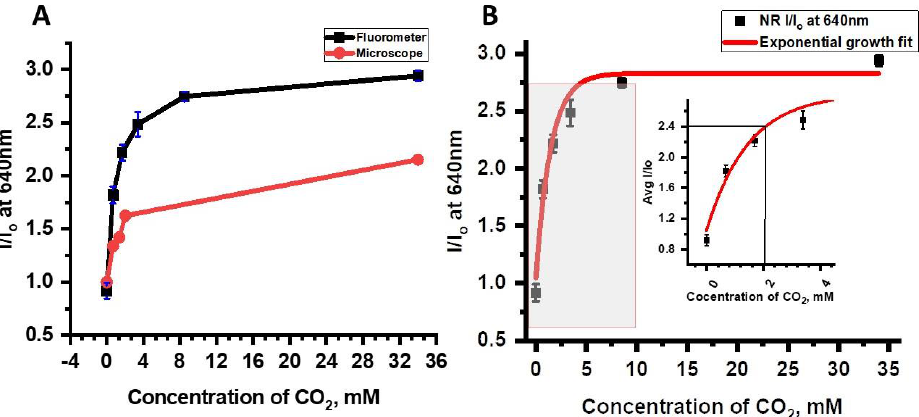
Figure 9. ( A ) Comparison of emission intensity changes for data acquired using a fluorometer and the microscope. The fluorometer data represents CO 2 gases at 0 mM, 0.68 mM, 2.04 mM, 3.4 mM and 34.0 mM concentrations, the microscope data represents CO 2 gases at 0 mM, 0.68 mM, 1.36 mM, 2.04 mM and 34.0 mM concentrations. ( B ) Calibration curve depicting the Limit of Detection (LoD) for the NR buffer solution purged with different concentrations of CO 2 and N 2 gases at pH 7.3 buffer solution. The data points are extracted from the absorption data which can be found in Figure S6. The arrow in the inset points is at the LoD value for the NR system. Table 5. Exponential equations for luminescence intensity changes in dCO 2 concentration for mi- croscope and fluorometer studies.